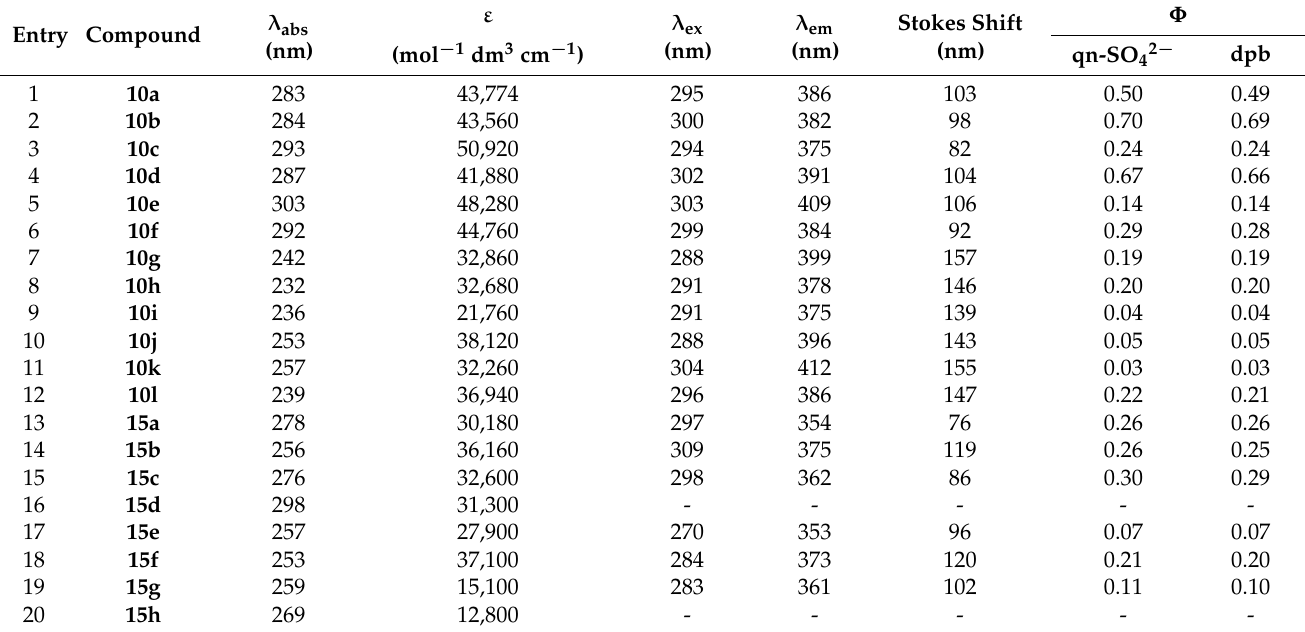
Table 3. Spectroscopic data for the studied s -tetrazine derivatives. λ abs —wavelength of absorption max- imum directly preceding λ em . λ ex and λ em —excitation and emission wavelength at global fluorescence maximum. Stokes shift was calculated as λ em − λ abs . UV-Vis absorption and 3D fluorescence